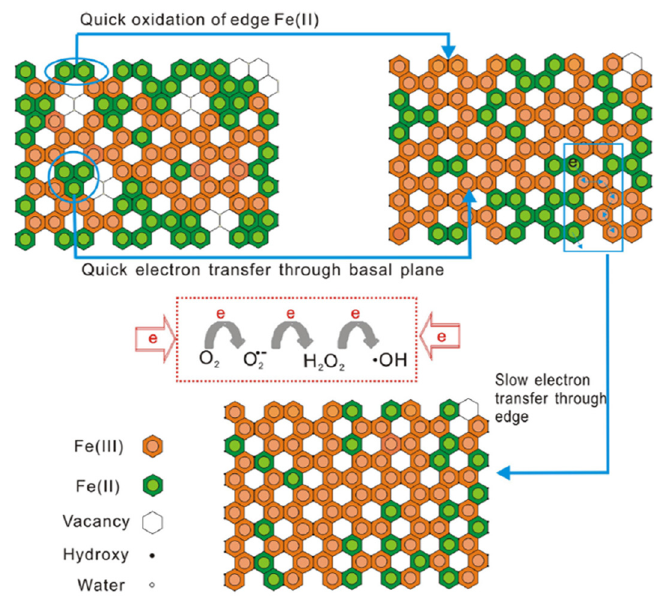
Figure 9. Scheme of the mechanism behind the electron transfer from tri-octahedral or di-octahedral to O 2 for generation of •OH radicals. Reprinted from [123] with permission from Elsevier (License Number